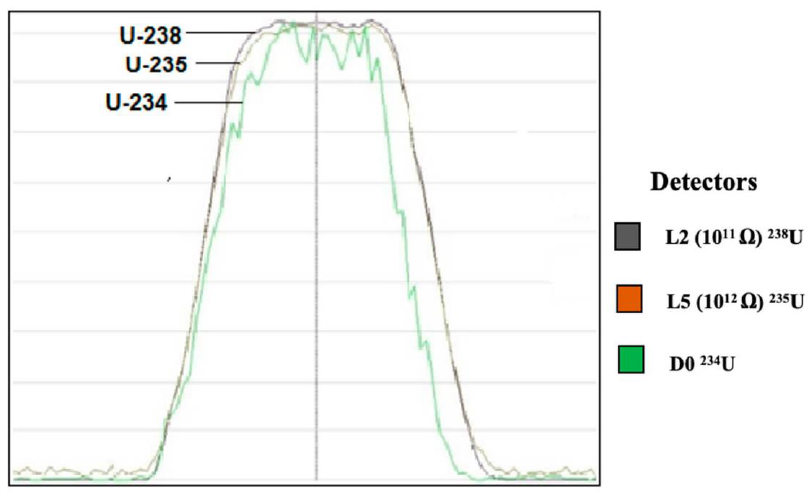
Figure 3. Multi scan of uranium isotopes in 50 ng mL −1 ((Two Faraday cups; L2— 238 U and L5— 235 U) and (Daly detector; D0— 234 U)).